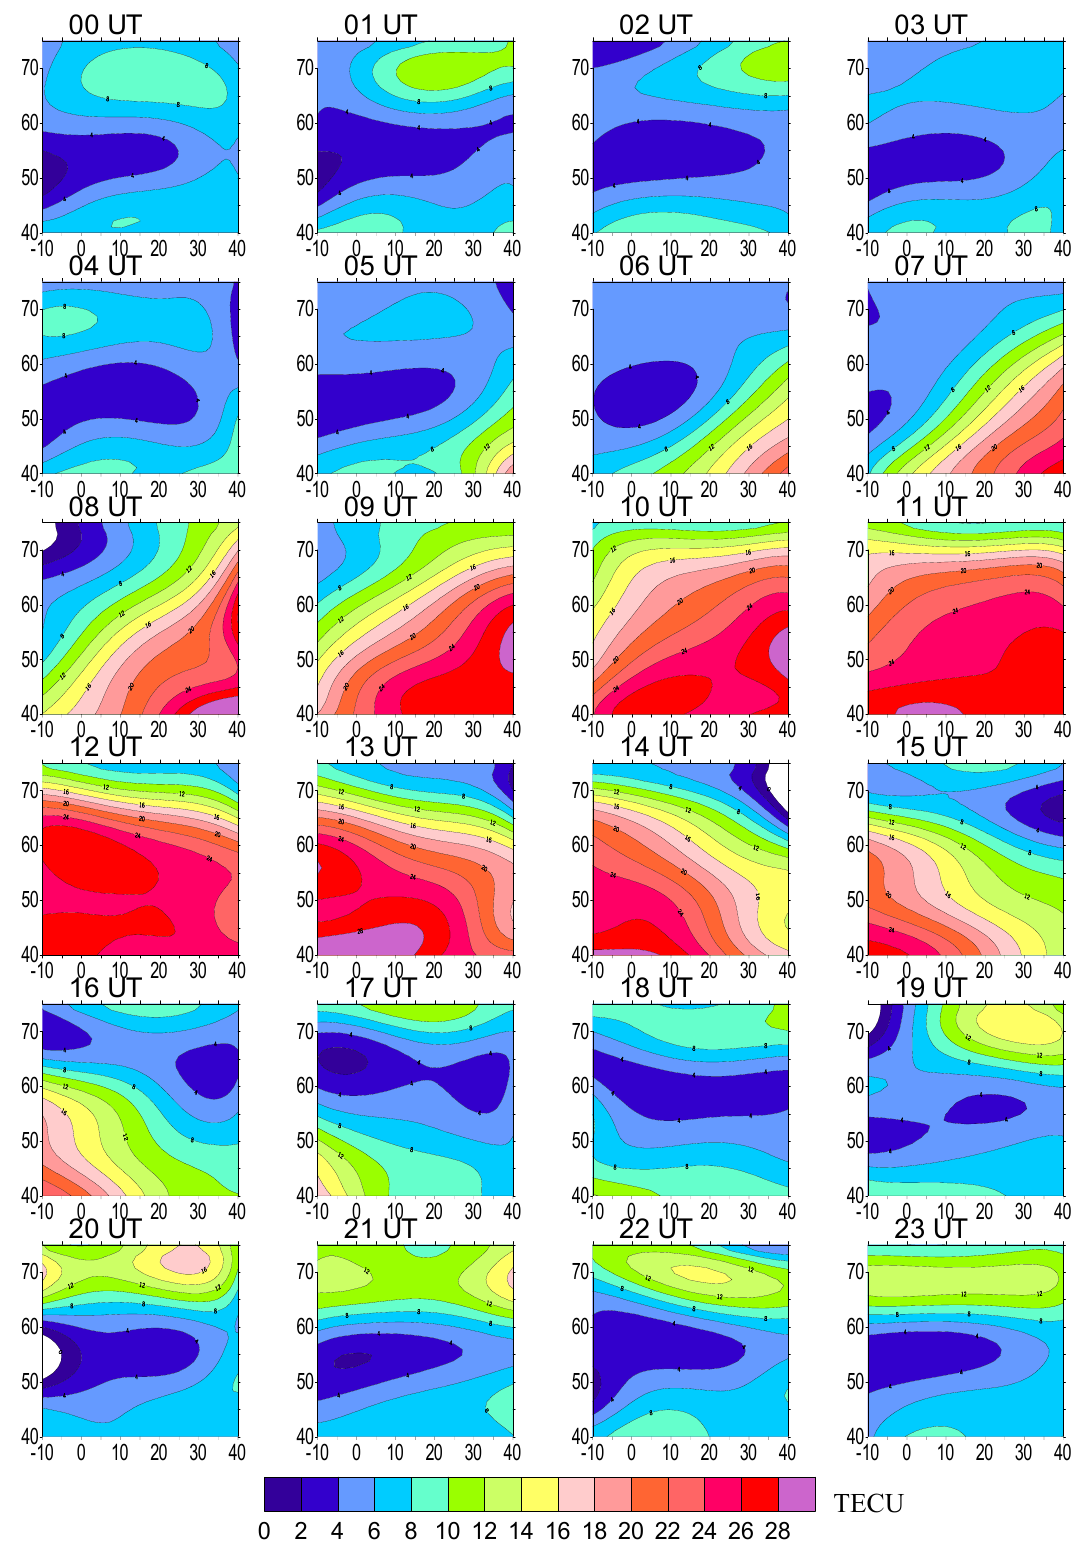
Fig.1 TEC maps for 7 December 1999. The plots demonstrate the development of the trough over Europe.